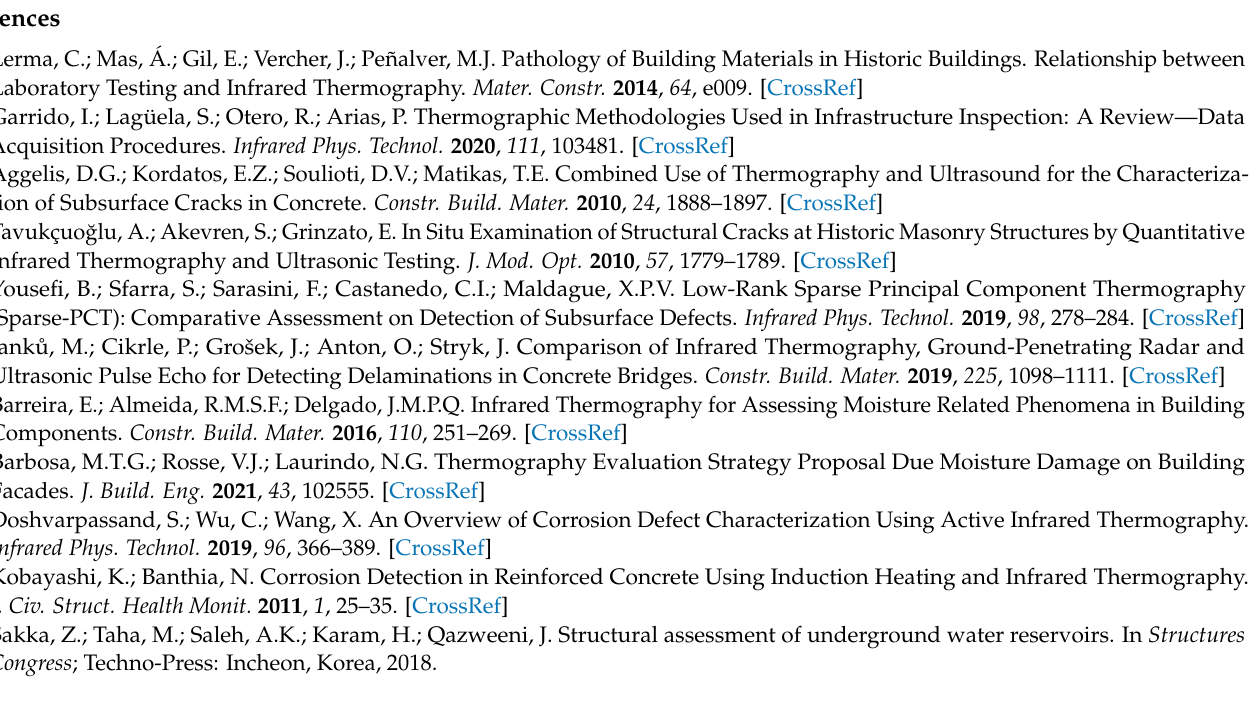
Figure A1. Thermal image, analyzed with the continuous wavelet transform (CWT) using the complex Paul function at a scale of 𝑎 (cid:3404) 20.